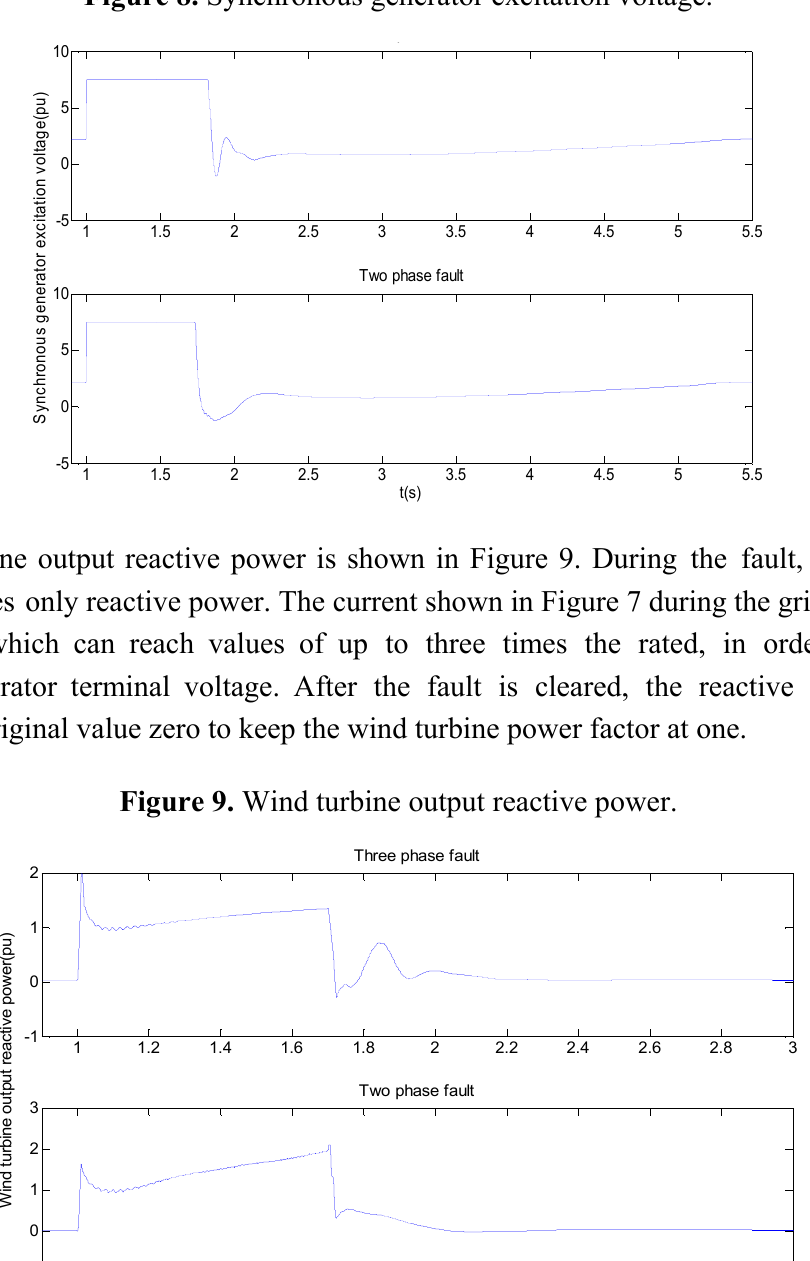
Figure 8. Synchronous generator excitation voltage.